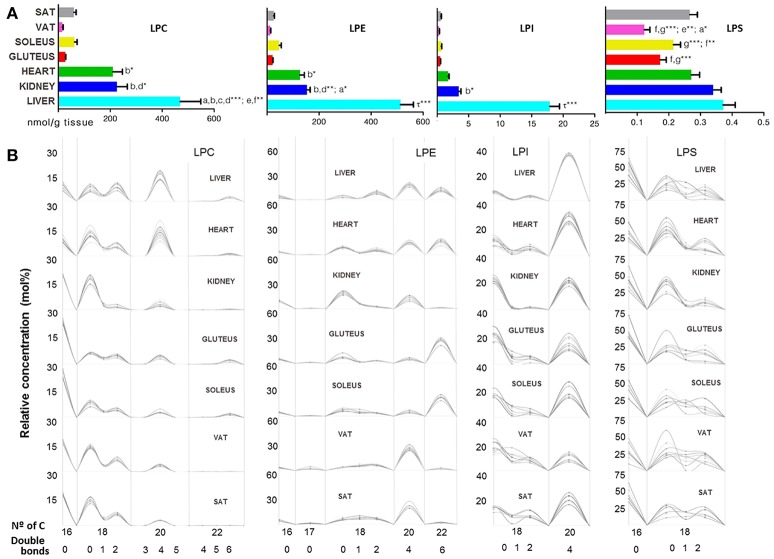
Lysoglycerophospholipids within mammalian tissues detected by targeted lipidomic analysis. (A) Concentration of LPC, LPE, LPS, and LPI subclasses. Values are expressed as mean ± SEM from 8 to 10 animals. Statistical analysis was one-way anova and post-hoc Tukey significance is represented in the bar chart, meaning a significantly different respect to SAT, b respect to VAT, c respect to soleus, d respect to gluteus, e respect to heart and f respect to kidney, g respect to liver, τ respect to all. *p < 0.05, **p < 0.01, and ***p < 0.001. (B) Relative concentration of lipids normalized per sample to the total abundance within this lipid class to obtain molar fractions. Each solid line indicated tissue from an individual rat. Gray vertical lines separate lipids by total number of acyl chain carbons. The number of double bonds is indicated below within each group.